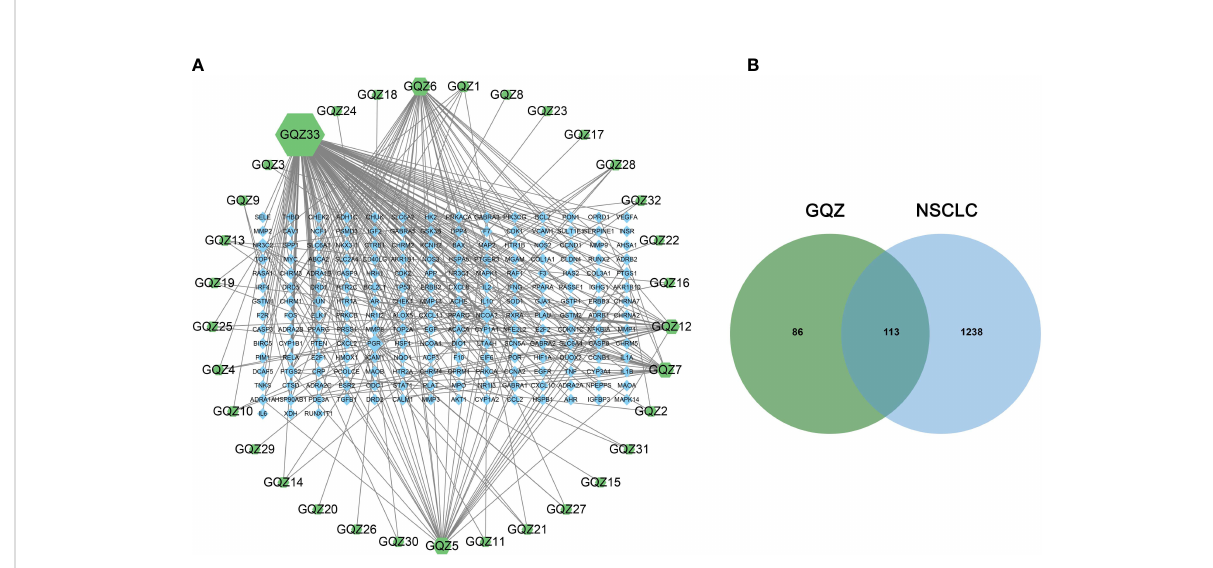
FIGURE 1 (A) Predicted target network formed by compounds in GQZ. Active compounds are represented by green nodes and predicted targets are represented by blue nodes. Each edge represents the interaction between each compound and target, with the node size being directly proportional to the degree of interaction. (B) Identi fi cation of the 113 matching predicted GQZ and NSCLC related